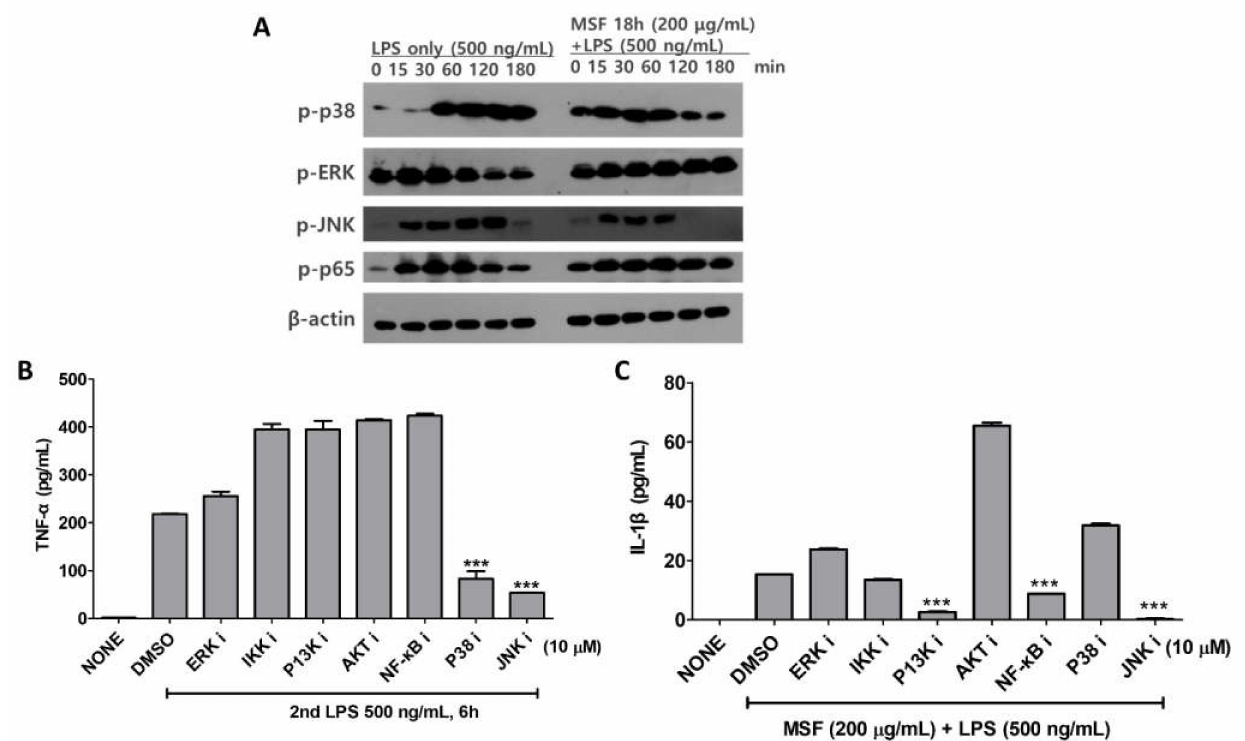
Figure 4. Signaling variation by MSF pretreatment. ( A ) THP-1 cells were pretreated with 200 µ g/mL MSF for 18 h and then re-stimulated with 500 ng/mL LPS for the indicated time. The levels of p-p38, p-ERK, p-JNK, p-p65, and β -actin were then quantified by western blot. ( B ) THP-1 cells were pretreated with dimethyl sulfoxide (DMSO) as a control and 10 µ M of inhibitors for 30 min and re-stimulated with 500 ng/mL LPS for 4 h. ( C ) THP-1 cells were pretreated with 200 µ g/mL MSF for 18 h and either DMSO or 10 µ M of inhibitors for 30 min. The cells were then stimulated with 500 ng/mL LPS for 4 h. The levels of cytokines in the culture supernatants were measured by ELISA. Statistical analysis was conducted with one-way ANOVA followed by Tukey’s HSD post hoc test. *** p <